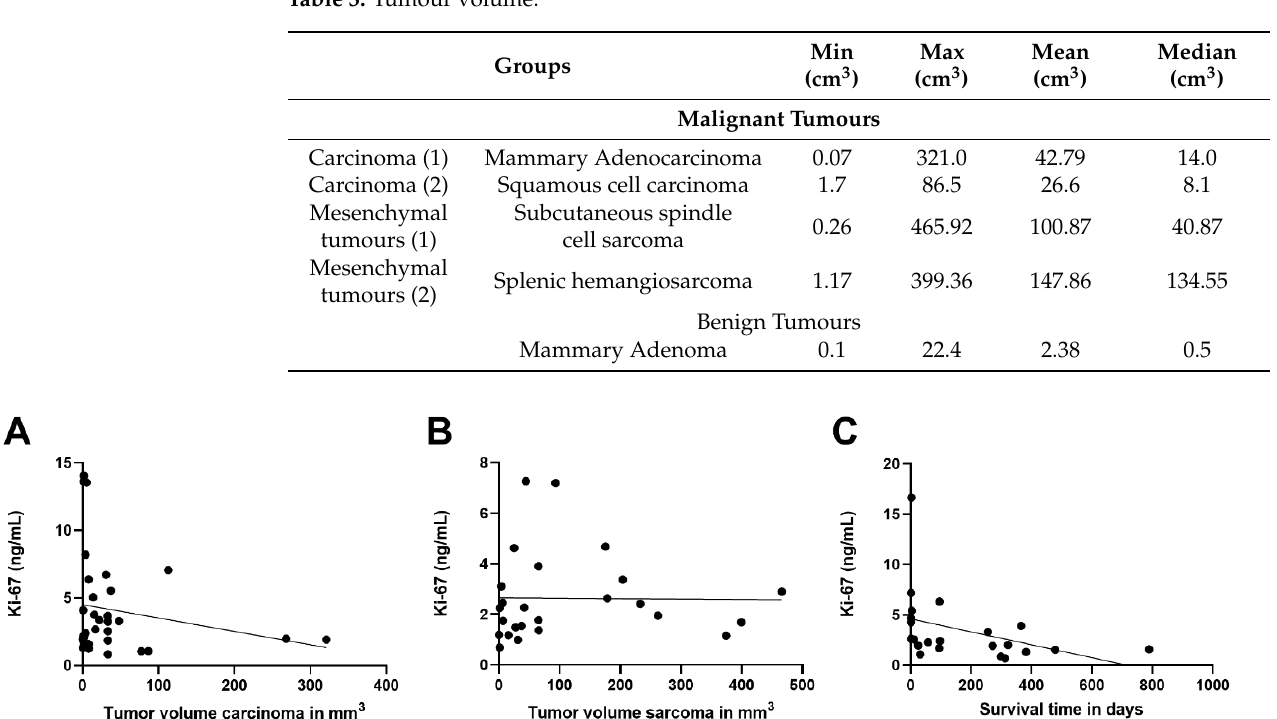
Figure 5. Linear regression analysis. ( A ) The influence of the tumour volume (mm 3 ) on the serum Ki-67 concentrations was measured by linear regression analysis for carcinoma. No significant relationship could be found ( p = 0.28; r 2 = 0.038). ( B ) Neither did the measured tumour volume (mm 3 ) of the sarcomas affect their Ki-67 concentrations also measured by linear regression analysis ( p = 0.955; r 2 = 0.0001). ( C ) The influence of the serum Ki-67 concentration on the survival time calculated with a linear regression analysis revealed no significant relation ( p = 0.075; r 2 = 0.15).